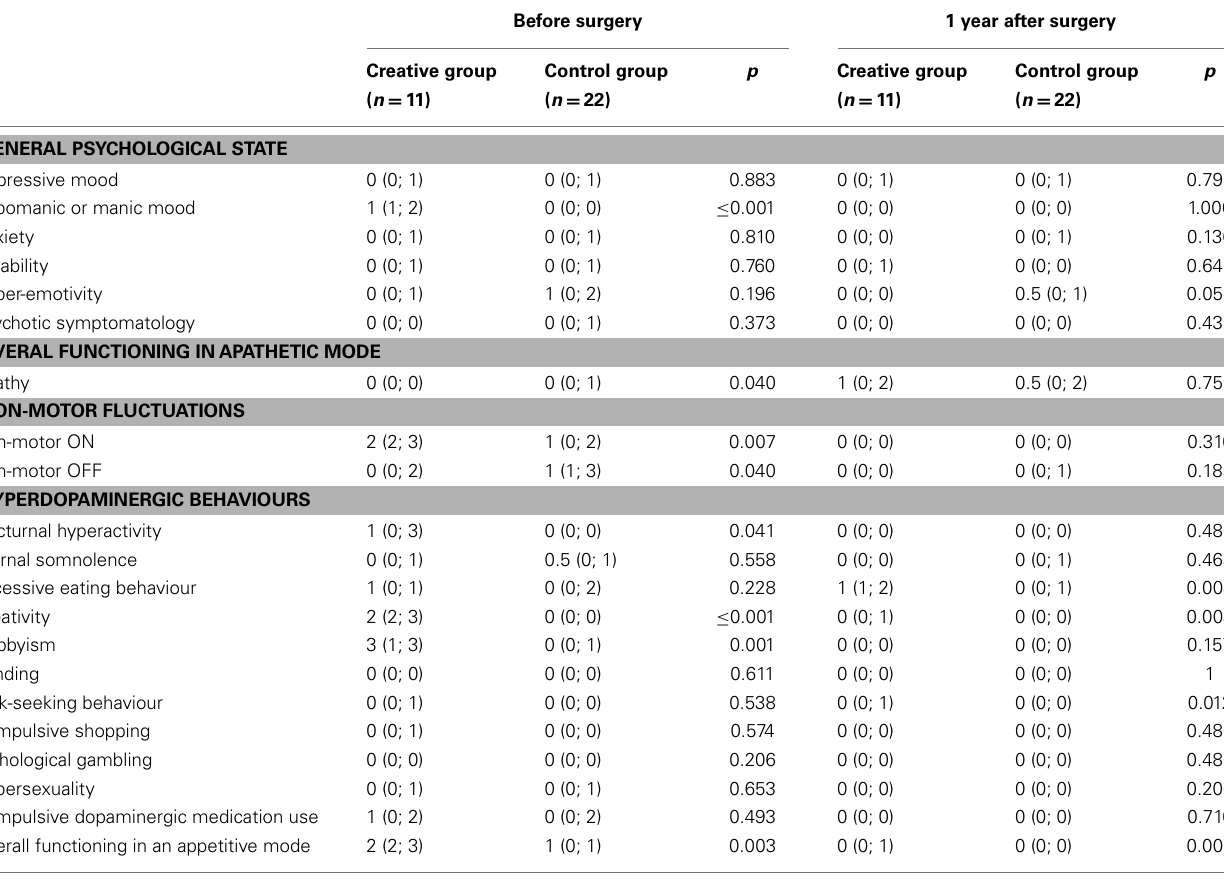
Table 3 |Ardouin scale scores expressed by median (25th; 75th percentile) before and 1year after surgery.